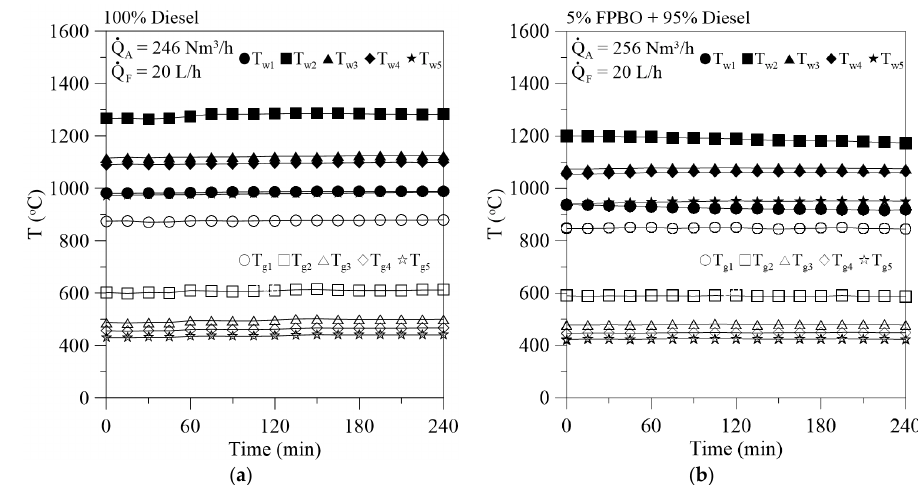
Figure 5. Temperature distributions with time for burning ( a ) diesel alone; and ( b ) the blend of 5% FPBO + 95% diesel.